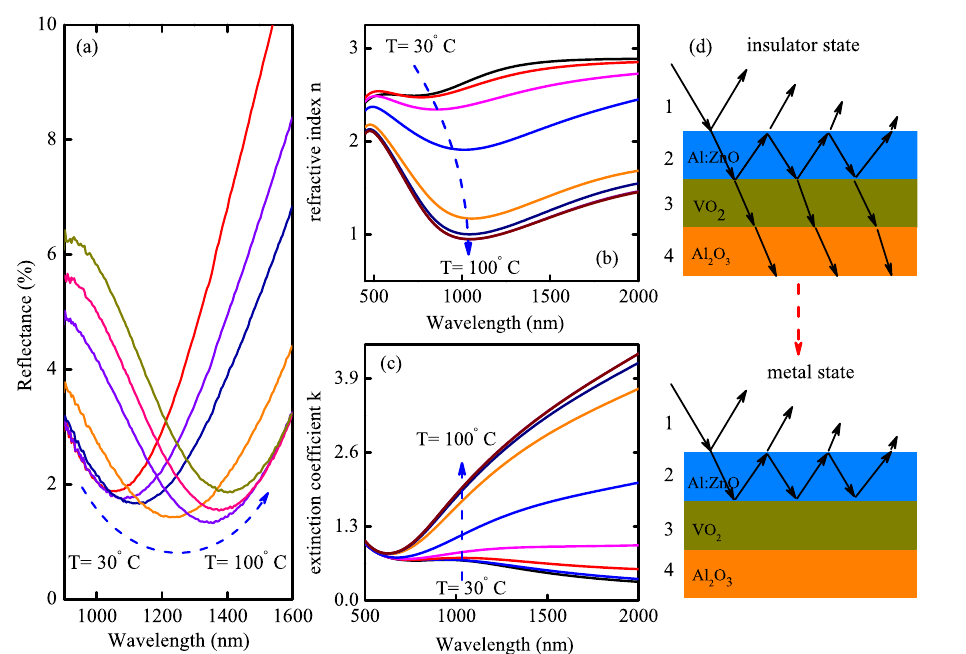
Figure 4. ( a ) The detailed red-shift of the absorption valley at the wavelength range of interest. ( b , c ) The temperature dependent of refractive index and extinction coefficient for the bare VO 2 film, respectively. ( d ) The schematic of the Fabry-Perot type cavities comprising the insulator and metal state of VO 2